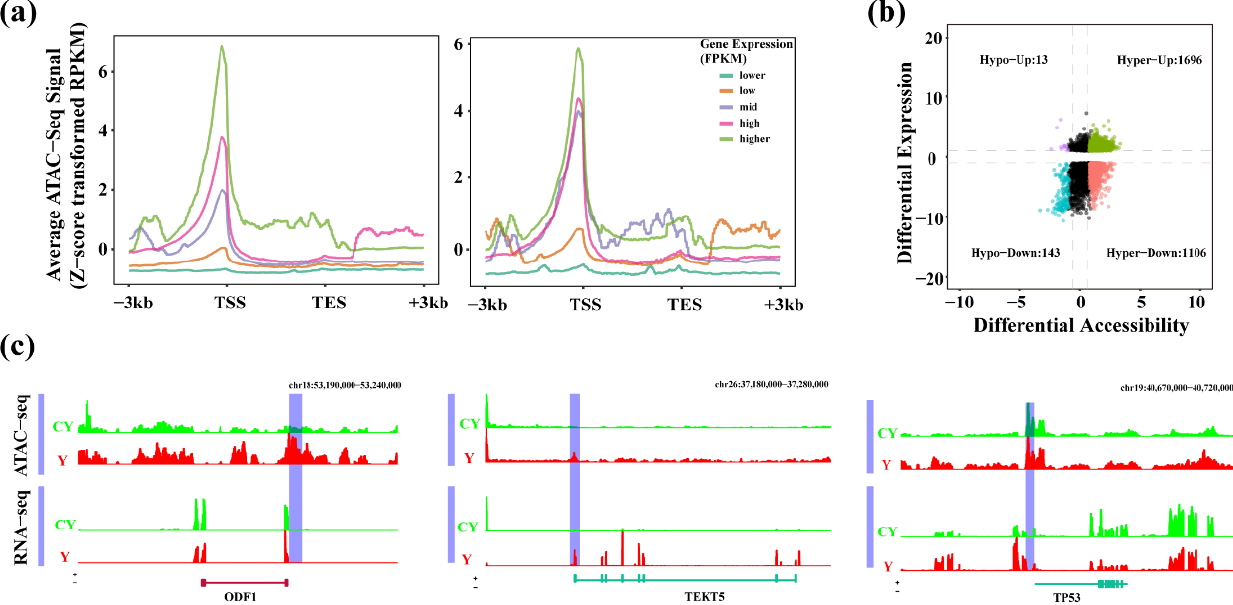
Figure 3. Correlation between ATAC signal and the gene expression in cattle-yak and yak groups. ( a ) ATAC signal and its potential relationship between upstream and downstream 3 kb and the gene expression, ( b ) Promoter region difference OCRs related genes and DEGs correlation analysis diagram, ( c ) Visual display of ATAC-seq and mRNA- seq signals in ODF1 , TEKT5 and TP53 genes.